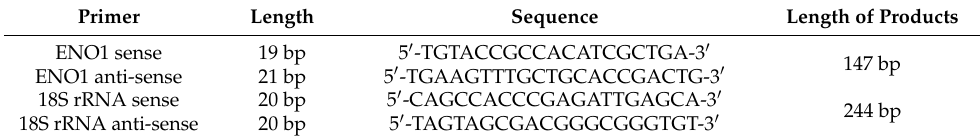
Table 1. The primers used here for